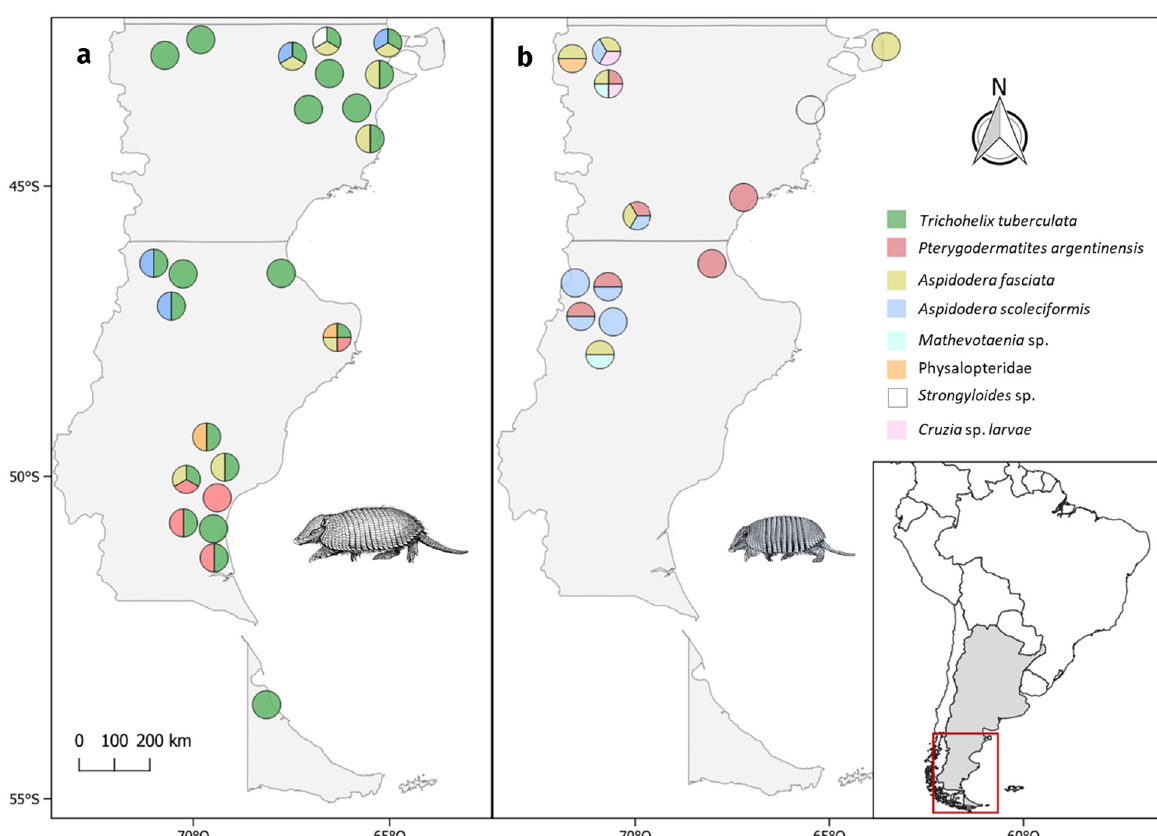
Figure 1. Sites of sample collection in Patagonia and helminthes species found in Chaetophractus villosus (a) and Zaedyus pichiy (b). Illustrations modified from Díaz & Barquez (2002), and Parera & Erize